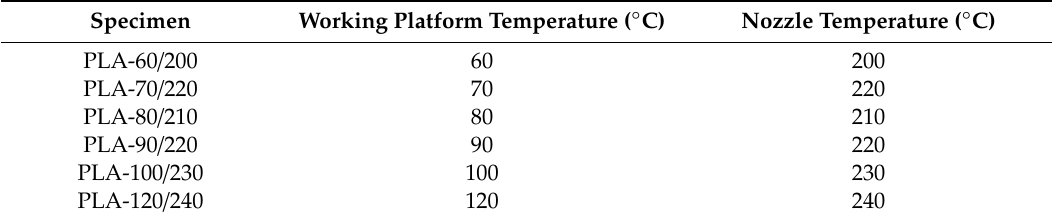
Table 5. Selected working platform and nozzle temperatures.